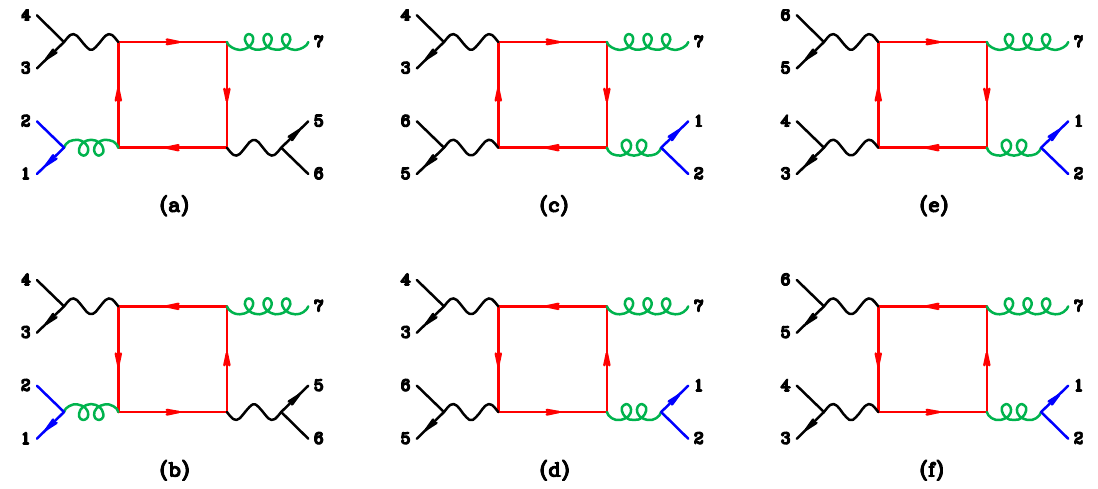
Figure 1 . Box diagrams containing a quark